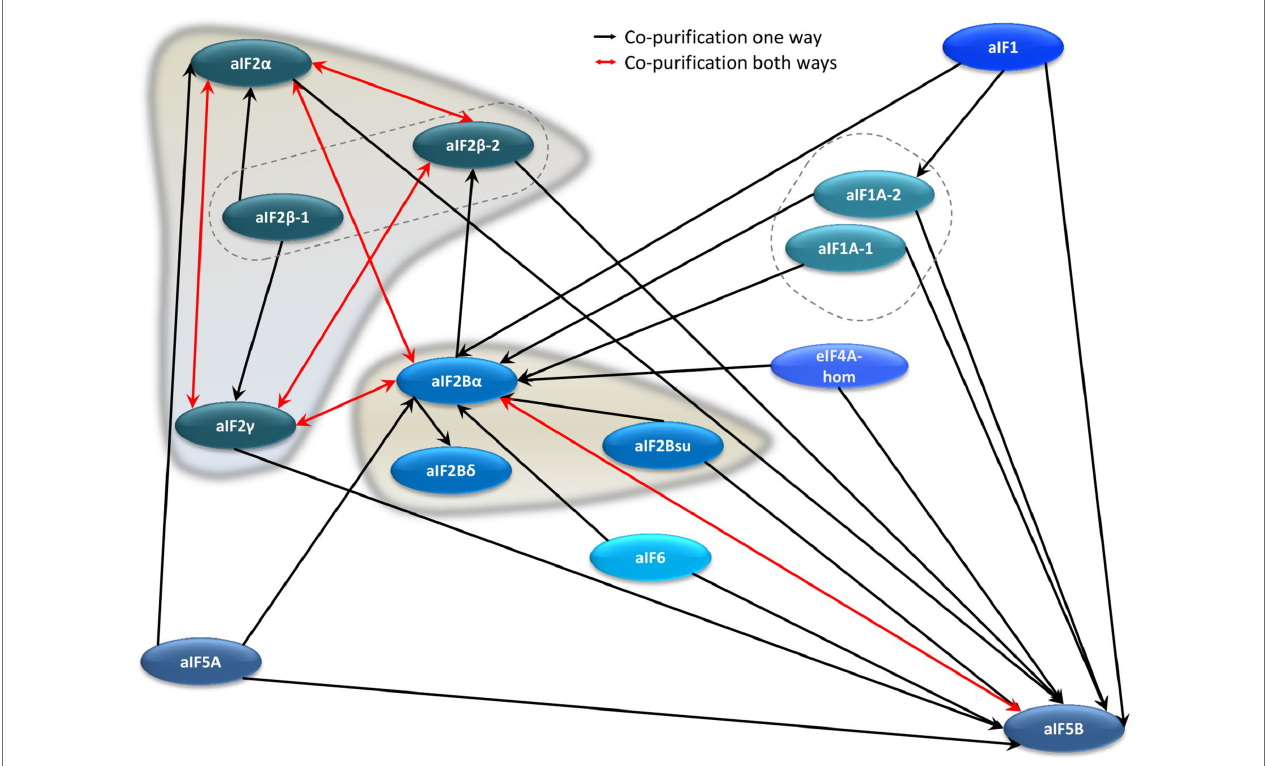
FIGURE 4 | Schematic overview of the aIF–aIF interaction network. Red arrows denote reciprocal co-purification, while black arrows depict one-directional co-